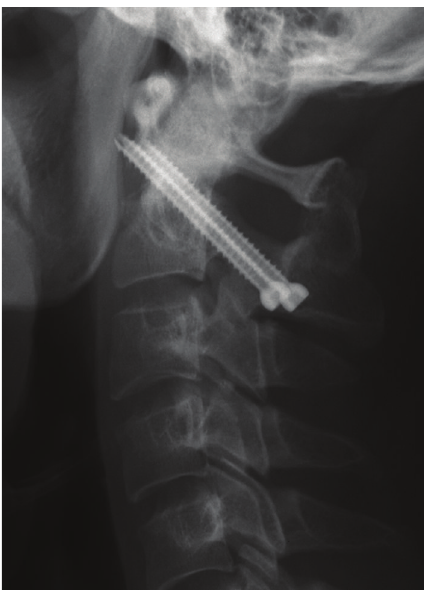
Figure 4: Postoperative cervical spine plain X-ray images. Atlanto- axial subluxation was improved with the adhesion of grafted